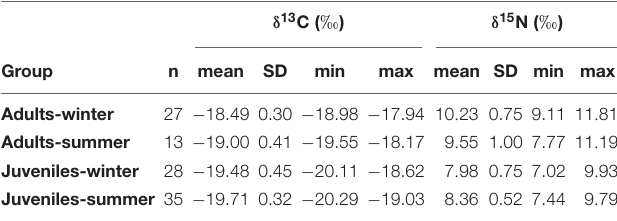
TABLE 3 | Summary table of δ 13 C and δ 15 N stable isotopes values of European hake for each age and season.